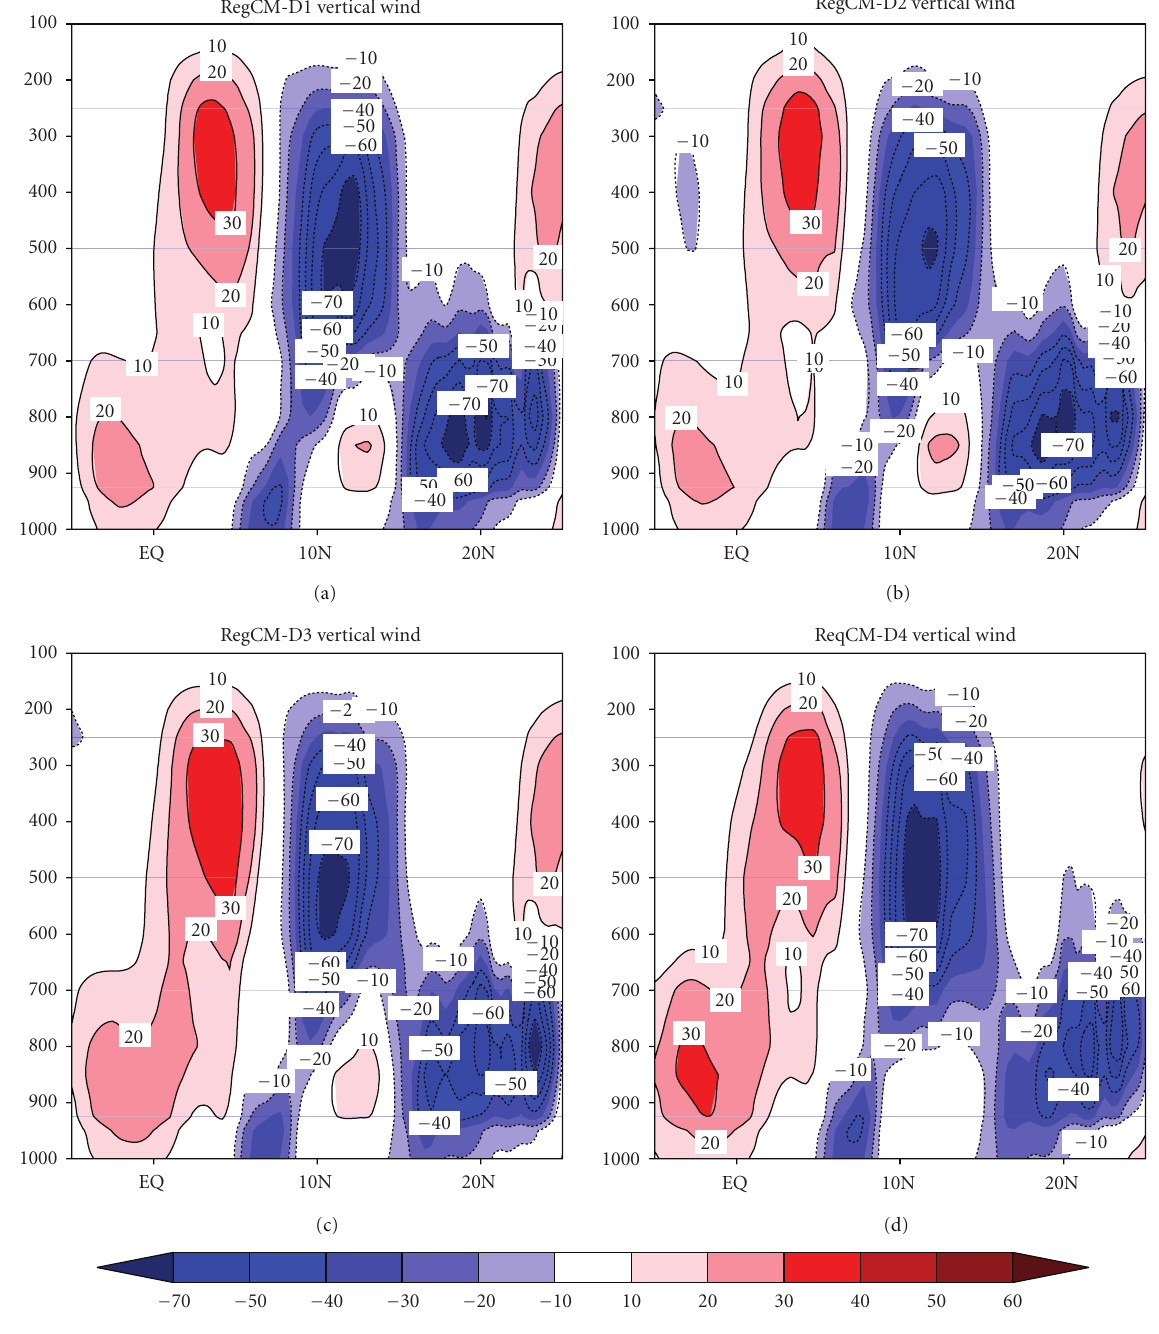
Figure 11: Mean JJA latitude-height cross section of vertical velocity averaged between 10 ◦ E–10 ◦ W for (a) RegCM-D1, (b) RegCM-D2, (c) RegCM-D3, and (d) RegCM-D4. Units are expressed in